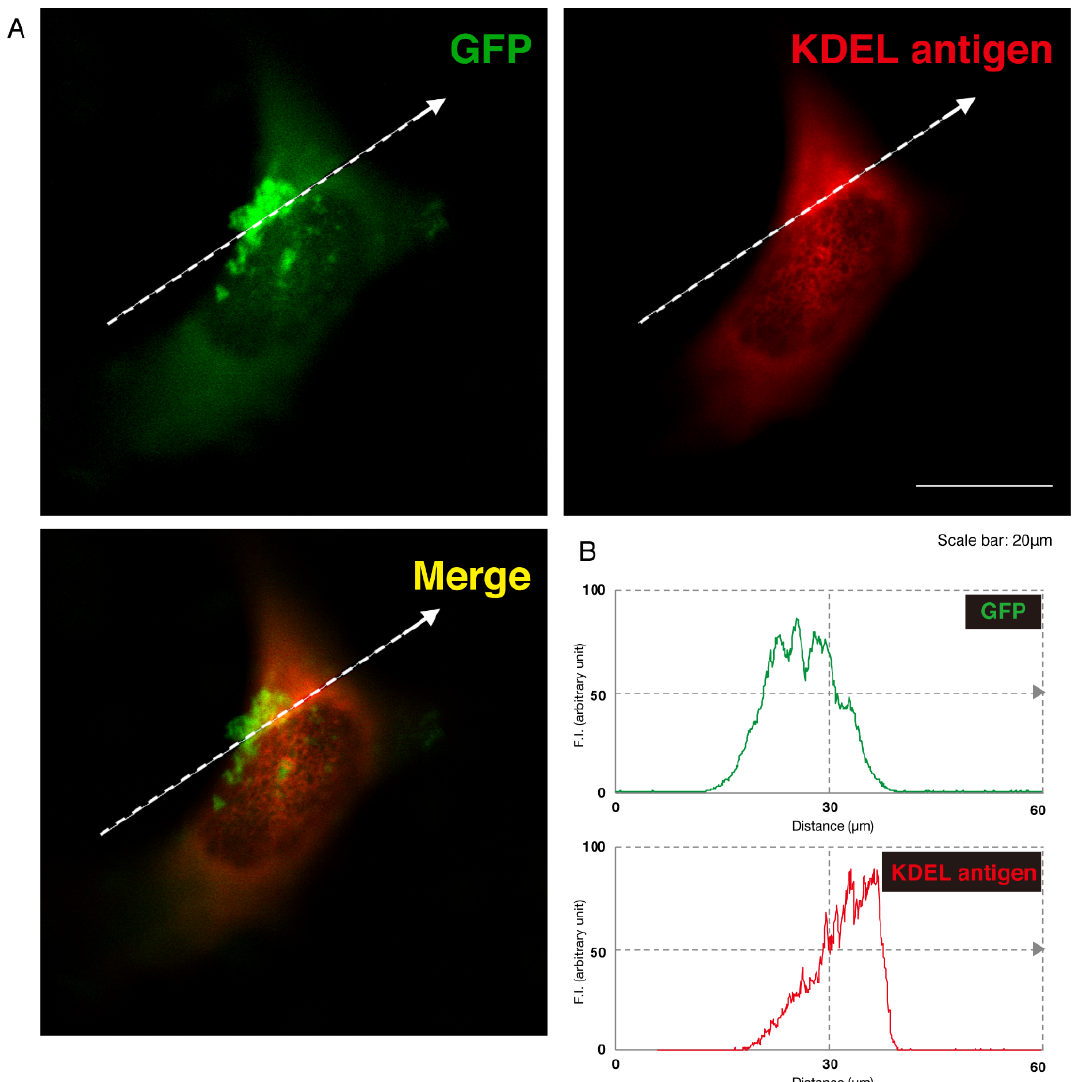
Figure 2. The 292CA mutant proteins of AIMP1 are not present in the endoplasmic reticulum (ER). ( A ) N1E-115 cells were transfected with the plasmid encoding the 292CA mutant construct of GFP-tagged AIMP1 (green). Transfected cells were stained with an antibody against the ER marker KDEL antigen (red). A merged image with a dotted arrow is also shown in the bottom panel. The scale bar indicates 20 μ m. ( B ) Fluorescence intensities (F.I., arbitrary unit) of green and red colors are shown along dotted arrows in A.